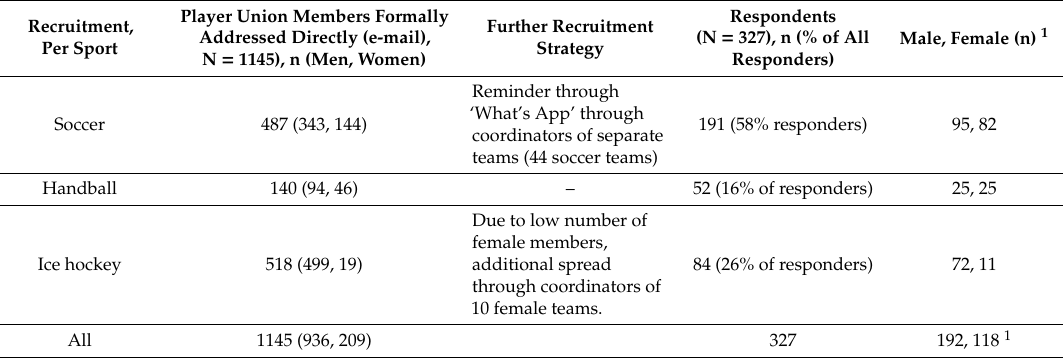
Table 1. Representation of sports and gender in the target population addressed with the online survey and in